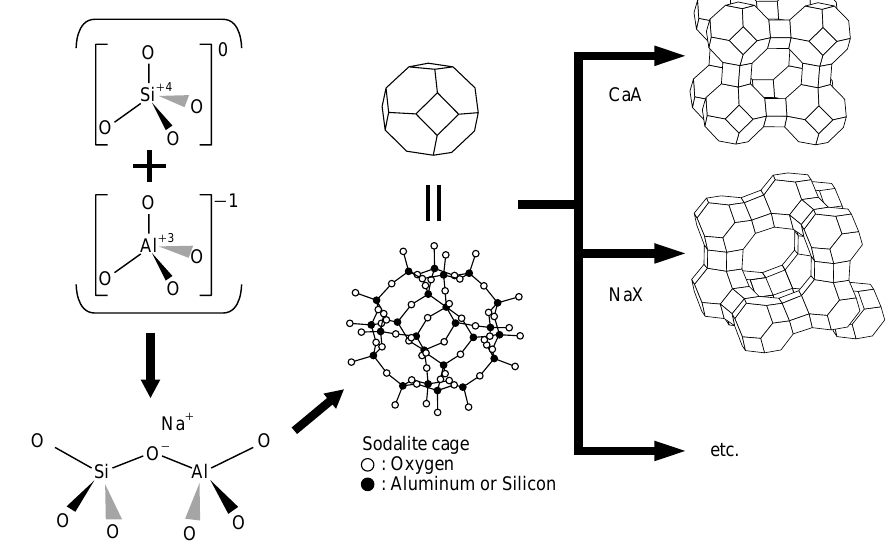
Fig. 3 Synthesis process and frame structure of